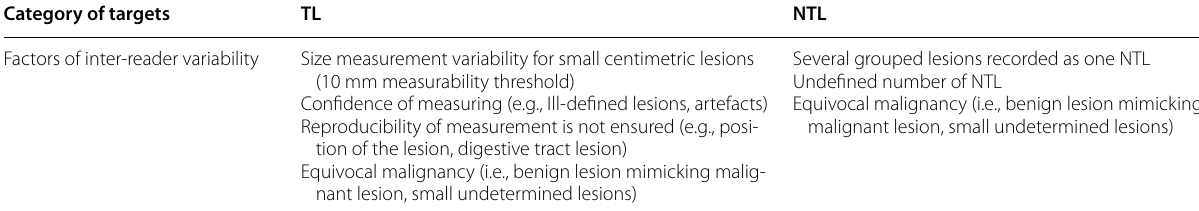
Table 1 Factors of inter-reader variability for selecting lesion at baseline following RECIST 1.1 guidance Category of targets